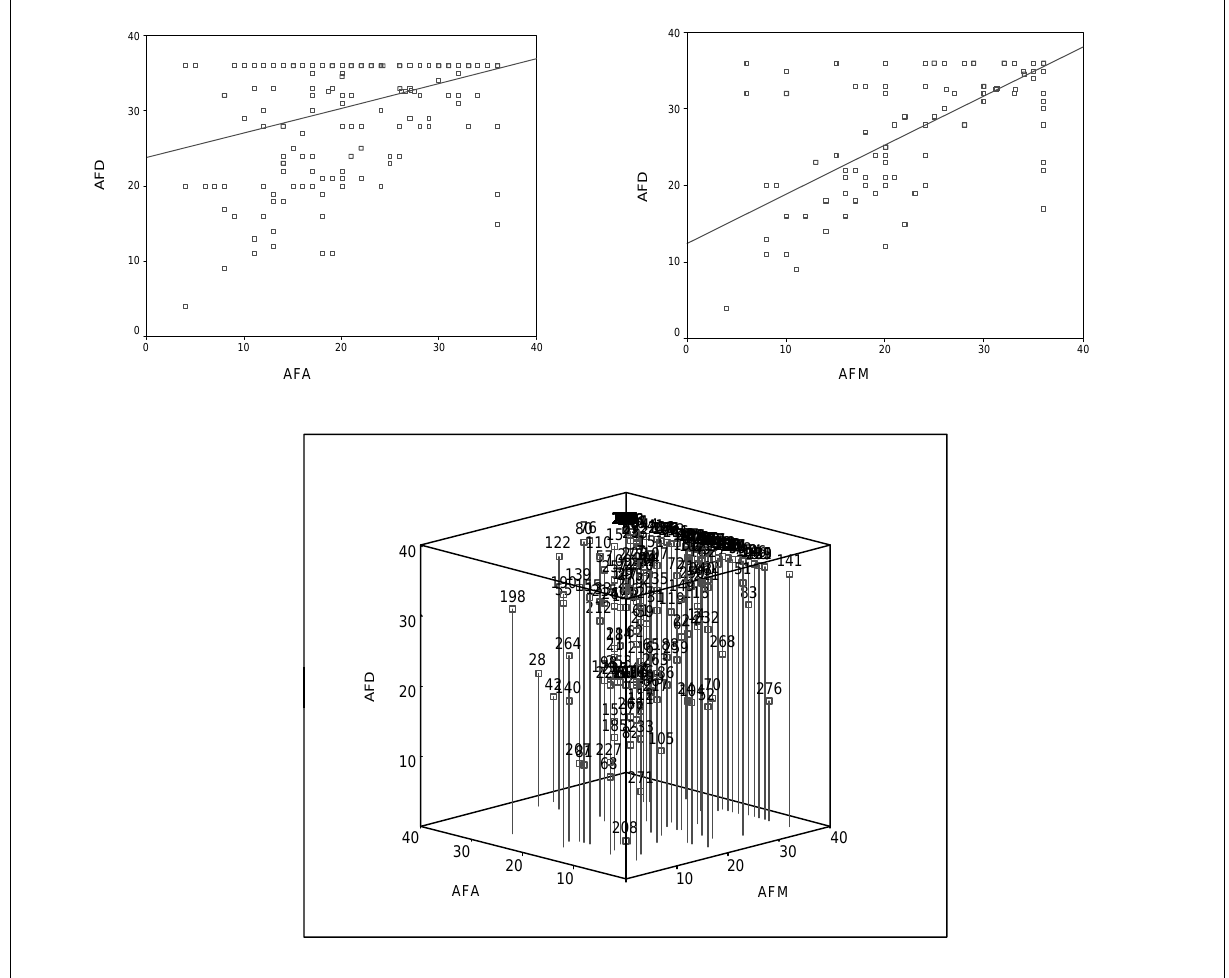
Figura 2. Gráfico da predição das atitudes frente ao uso de drogas pelas atitudes frente ao uso de álcool e